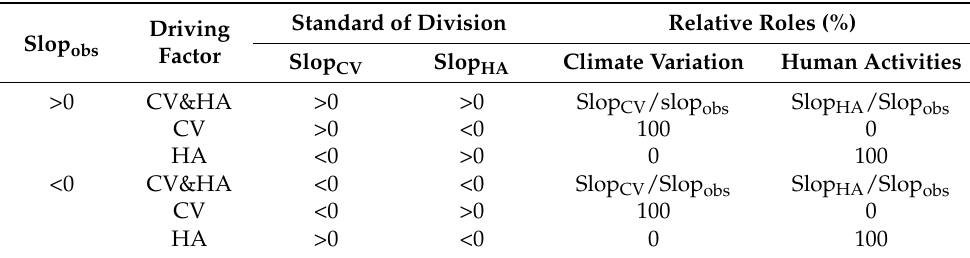
Table 2. Determination criteria of drivers of VEQI changes and the relative contribution of climate variation (CV) and human activities